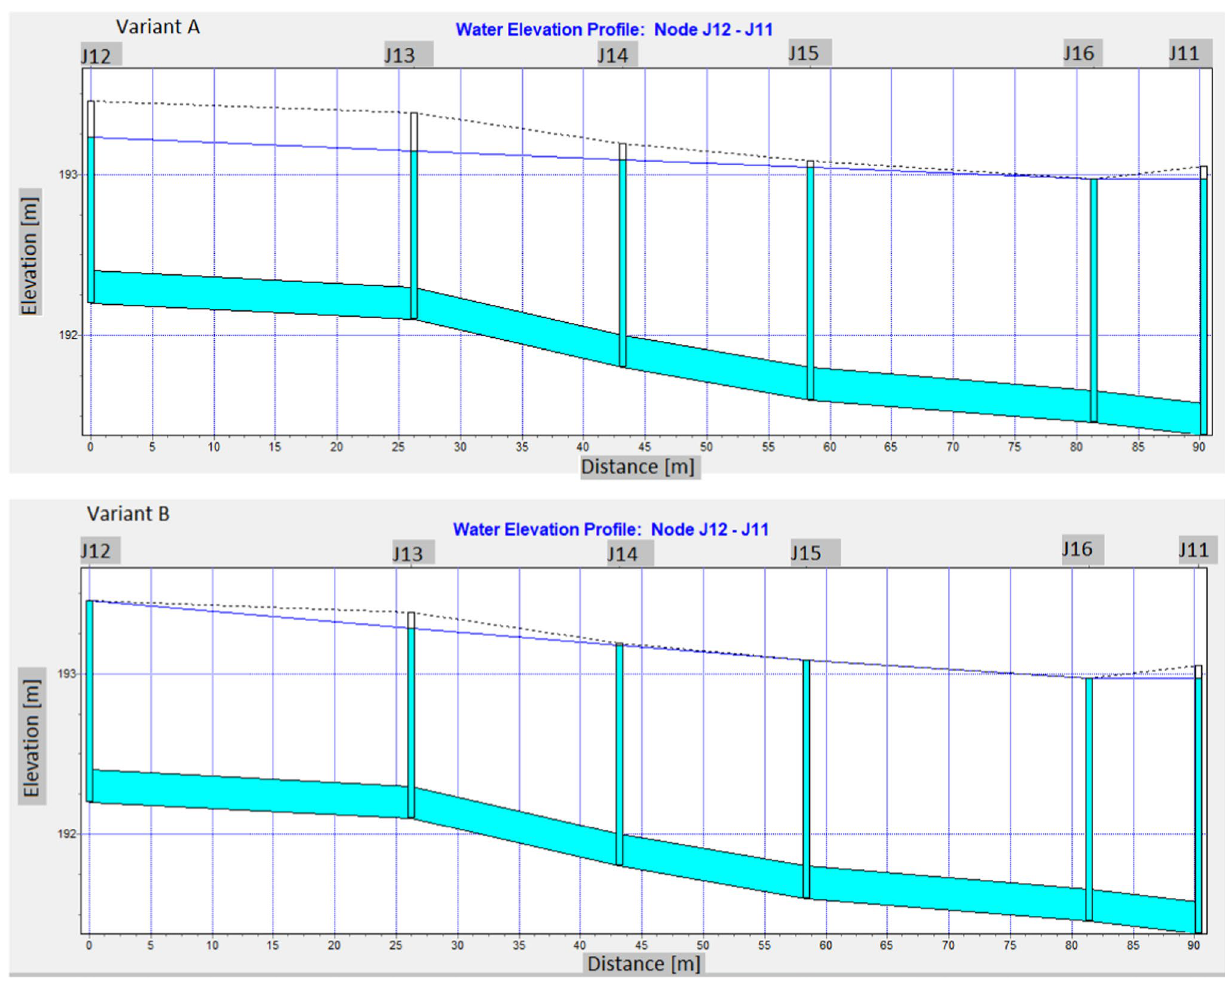
Fig. 5 Profile of the pipe section for rain No. II—variant A and variant B